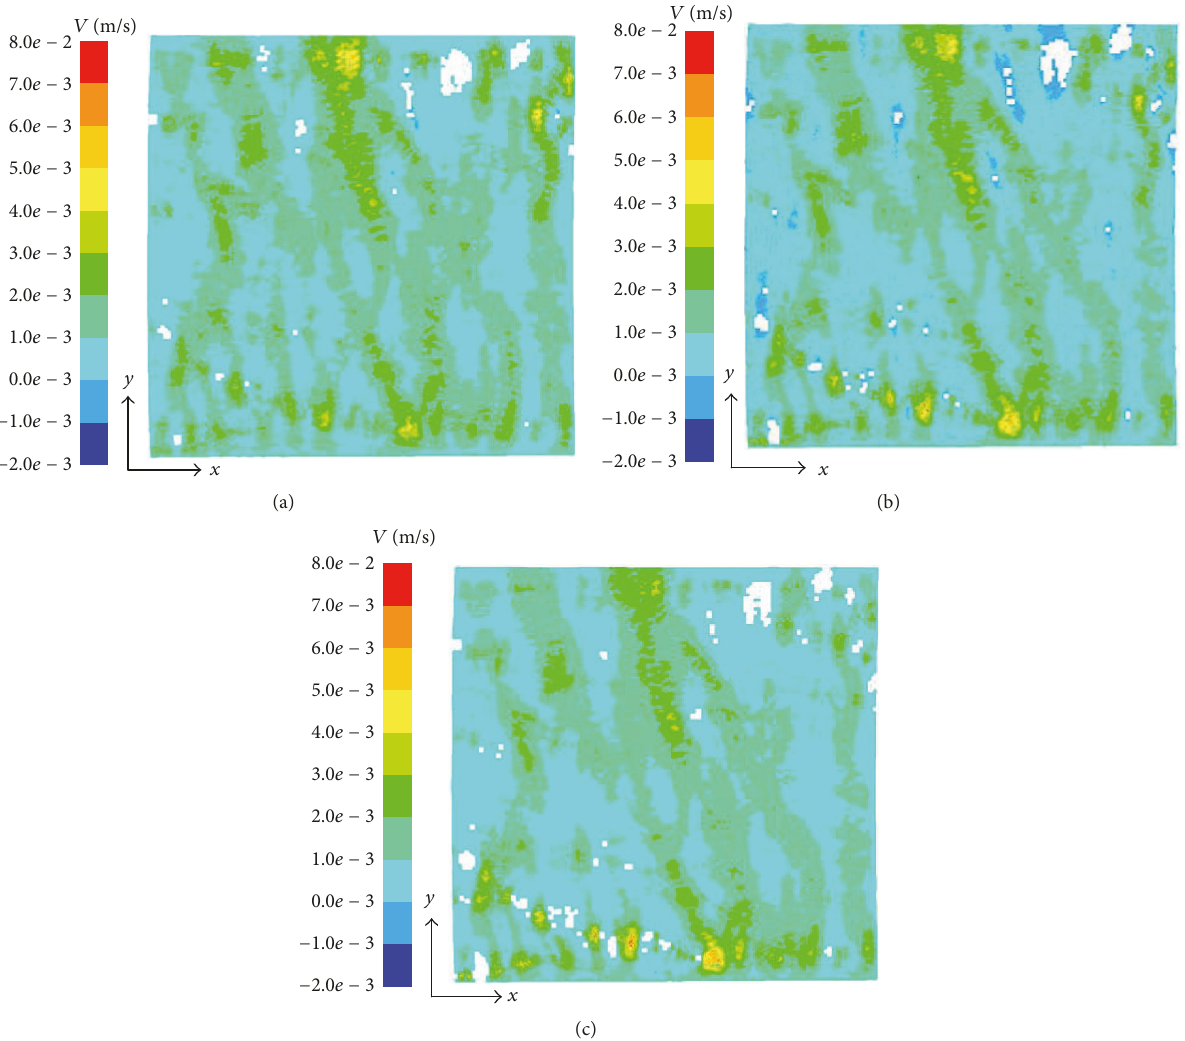
Figure 12: Velocity distribution ( 𝑦 direction) in the fracture Fr3 (unit: m/s) under different shear displacement: (a) 1.0 mm, (b) 2.0 mm, and (c) 3.0